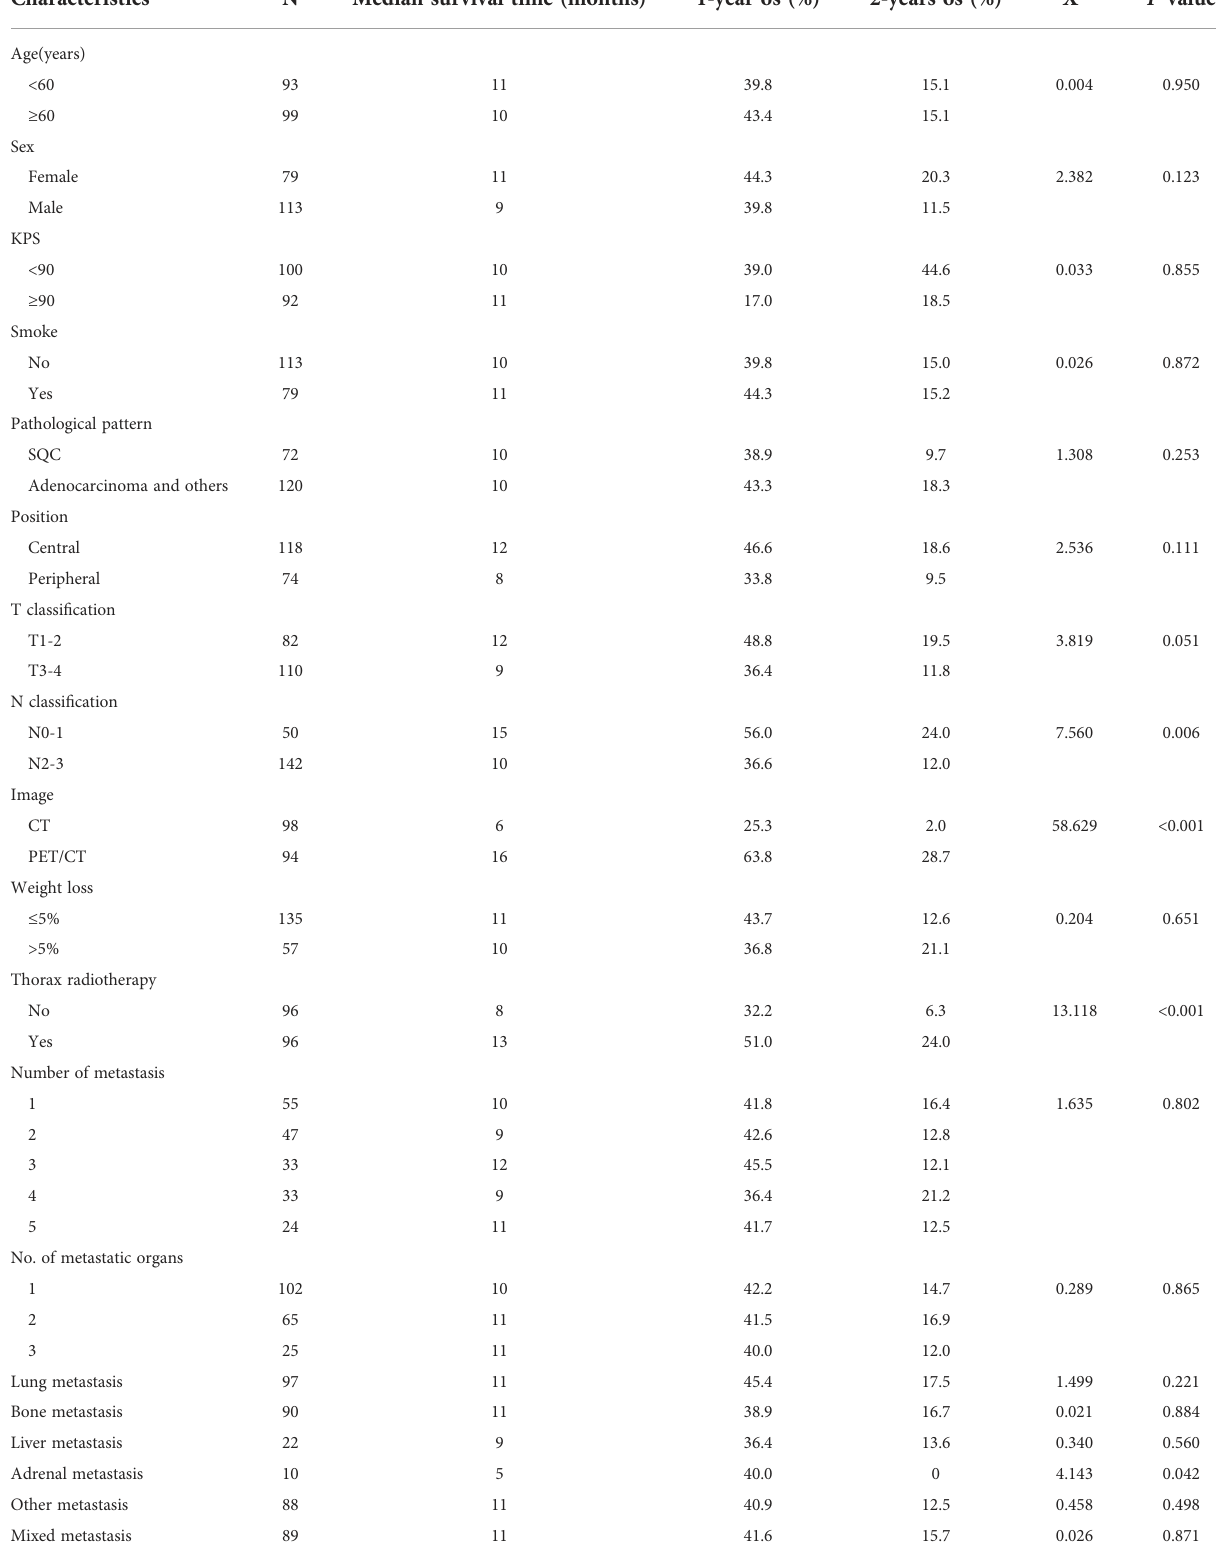
TABLE 2 Univariate analysis between prognostic factors and overall survival (Before PSM).